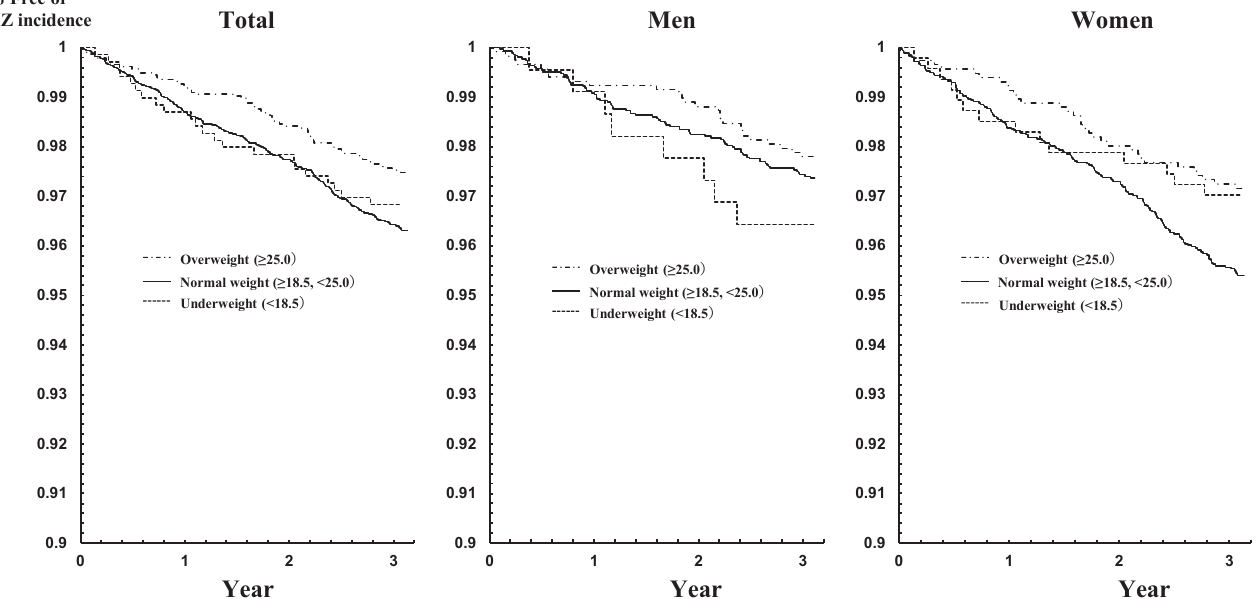
Figure 2. Kaplan-Meier plots of HZ incidence during the 3-year observational period among the three body mass index groups in all participants, men, and